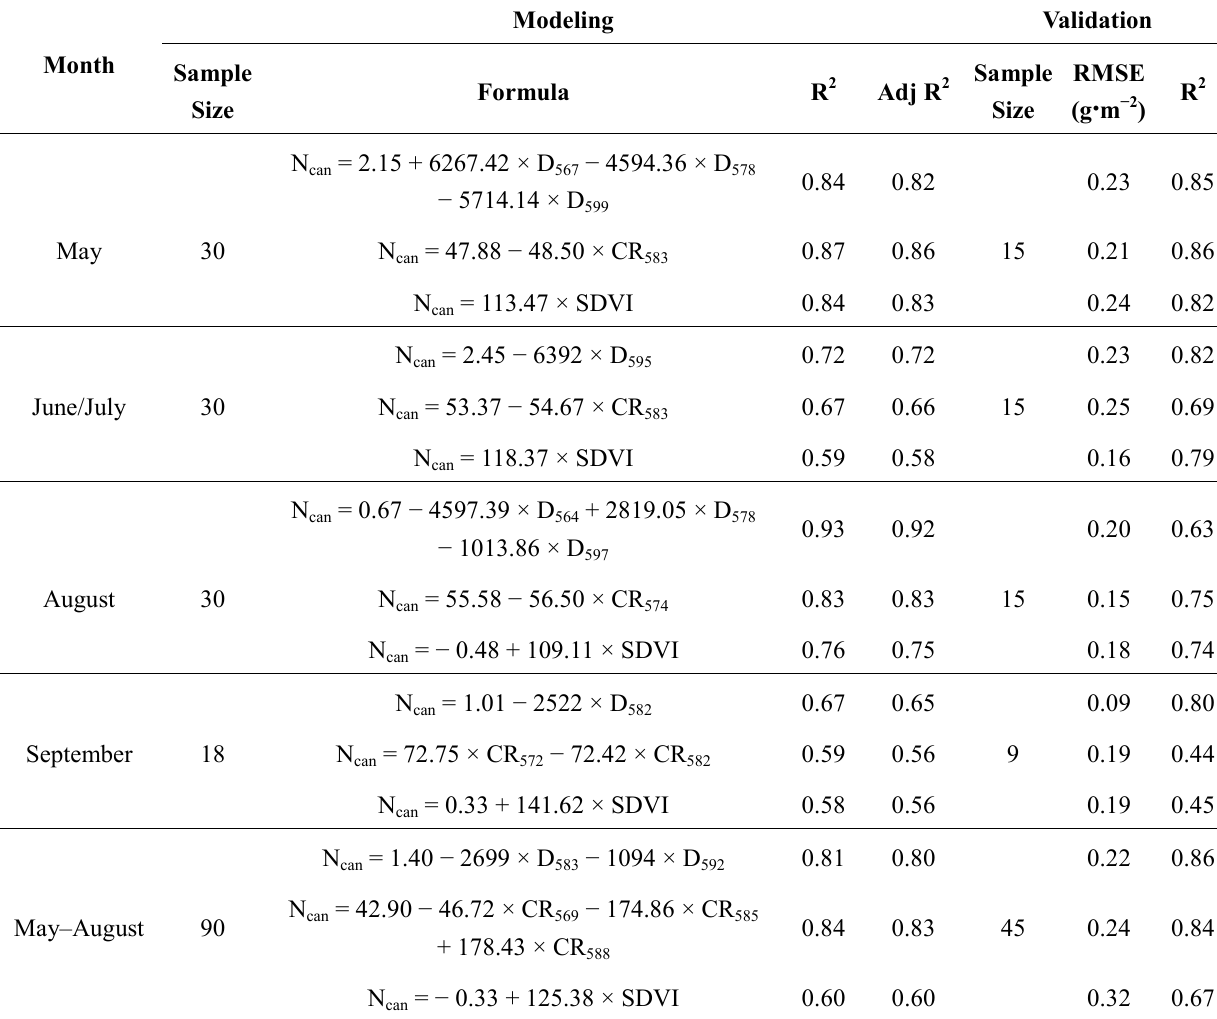
Table 6. Regression models for canopy nitrogen retrieval using derivative (D), continuum removed reflectance (CR) spectra and SDVI derived from aircraft